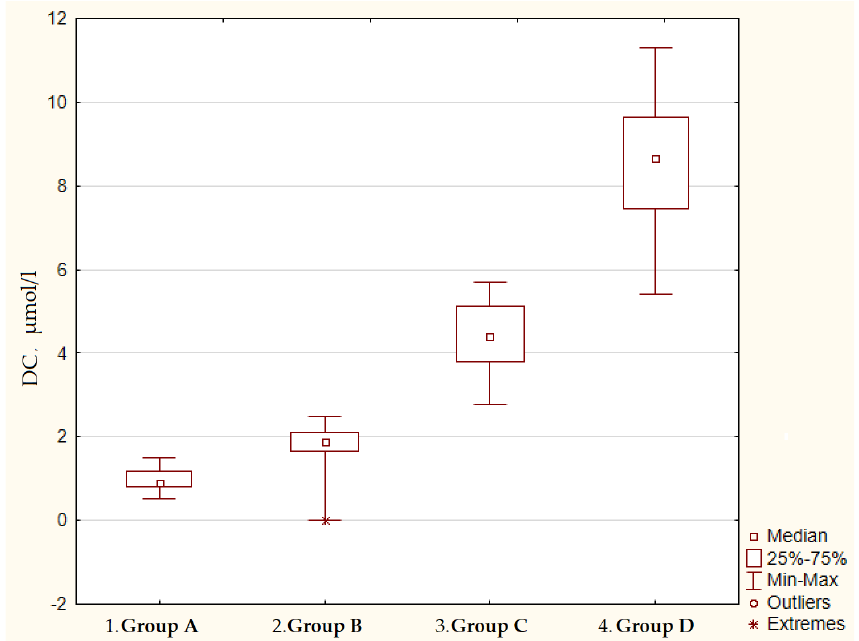
Figure 1. The content of diene conjugates in the blood plasma of patients with atrophic gastritis and gastric cancer.